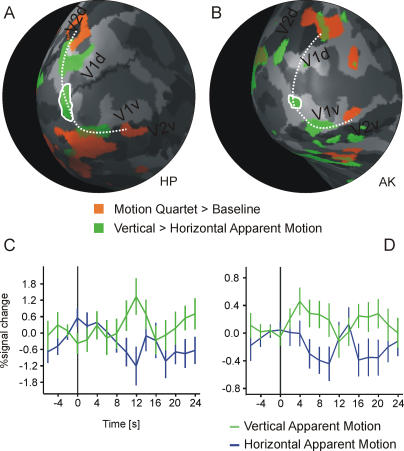
Results from the Bistable Motion Quartet (Experiment 3)(A and B) Medio-posterior view on the inflated left occipital cortex of subject HP (A) and AK (B) (all six subjects are shown in Figure S3). Gray shading indicates the extension of V1 (light gray for V1) and the cortex curvature (dark gray, concave; light gray, convex). Activation maps show the cortical representation of the stimulated locations in red (motion quartet > baseline). Contrast maps in green indicate regions that are more active for vertical apparent motion than for horizontal apparent motion (ROI-based GLM at indicated locations; HP: t[301] > 2.5, p < 0.02; AK: t[708] > 2, p < 0.05). The dotted line is a spline-interpolated curve connecting the stimulated locations and the region that is more active during the perception of vertical apparent motion. (This line does not necessarily indicate the path of apparent motion from experiments 1 and 2 since stimulus parameters had to be adjusted.)(C and D) The solid white lines mark regions from which event-related averages were calculated. Event-related averages are shown for subject HP (C) and for subject AK (D). The time courses are aligned to the time point at which the subject indicates a switch in perception (t = 0, black line) and are shown for the time period from 4 s before to 24 s after the perceptual switch. The first perceptual period following each stimulation onset is omitted from the analysis (see Materials and Methods). Error bars correspond to standard errors of the mean. For HP, the vertical percept lasted on average for 11.9 s (standard deviation, 10.3 s), the horizontal for 13.4 s (standard deviation, 9.2 s). For AK, the vertical lasted for 14.6 s (standard deviation, 7.1 s), and the horizontal for 16.6 s (standard deviation, 6.7 s).